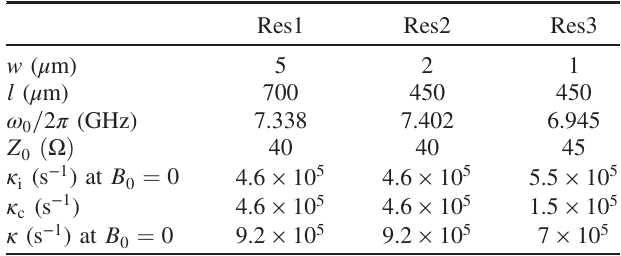
TABLE I. Resonator